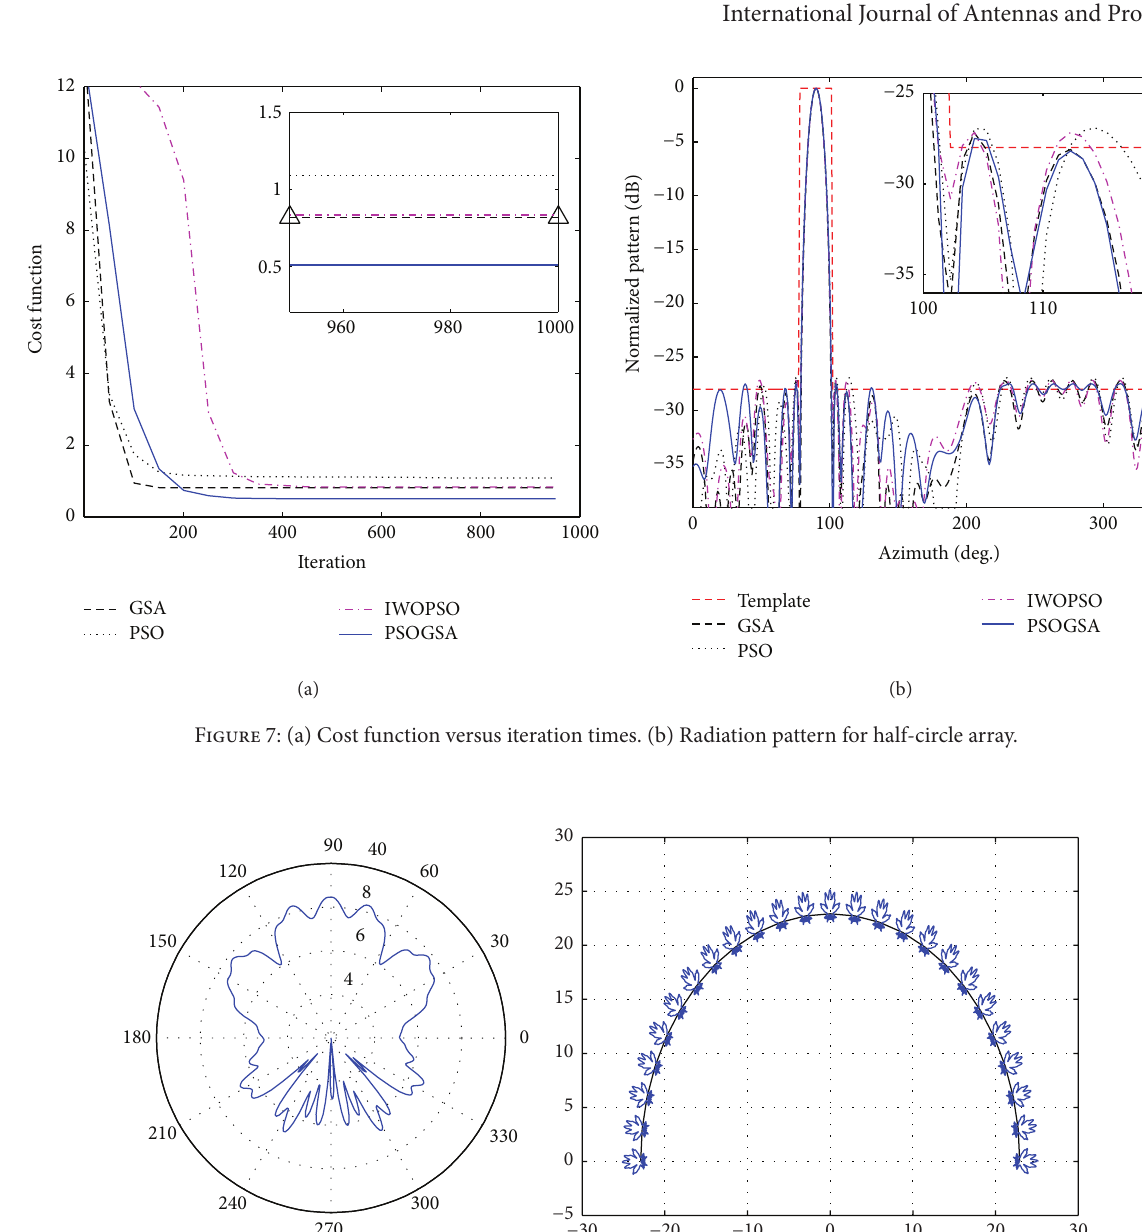
After the PSOGSA optimization, the excitation amplitude and phase obtained in coupled situation are shown in Table